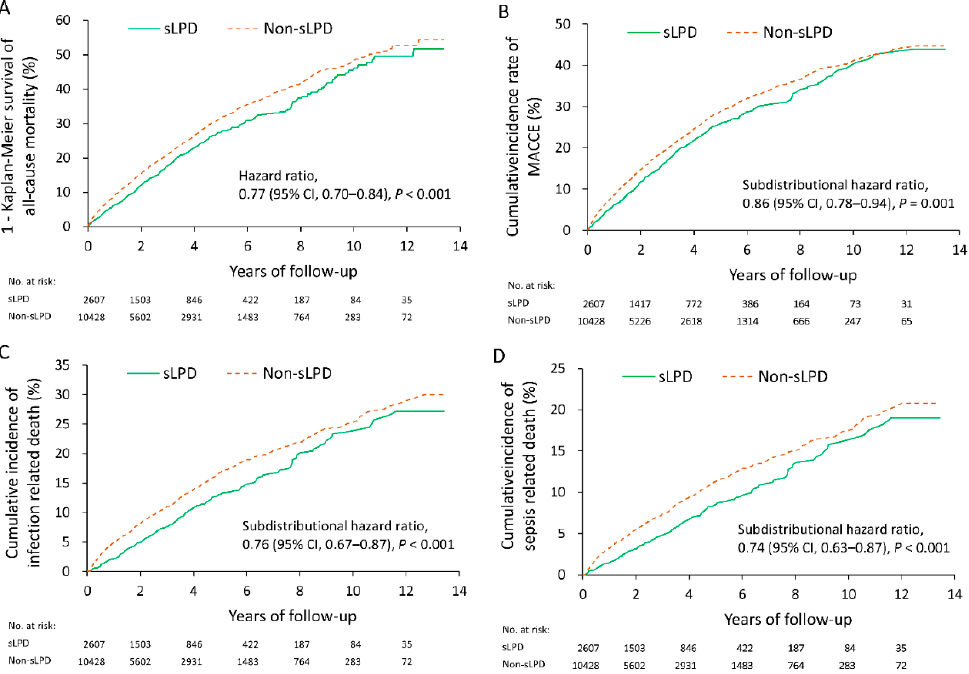
Figure 2. Kaplan–Meier survival curves for all-cause mortality ( A ) and cumulative incidence rates of major cardiac and cerebrovascular events ( B ), infection-related death ( C ), and sepsis-related death ( D ). CI: confidence interval. Table 2. Follow-up outcome at the last follow up.